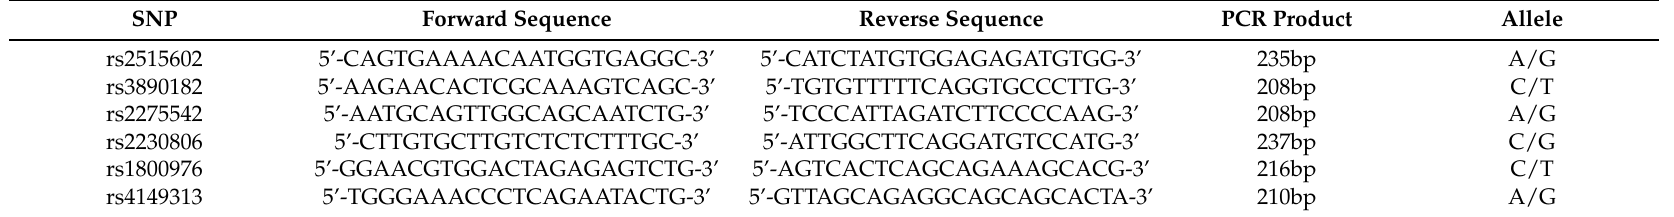
Table 1. The sequences of forward and reverse primers for genotyping of the ABCA1